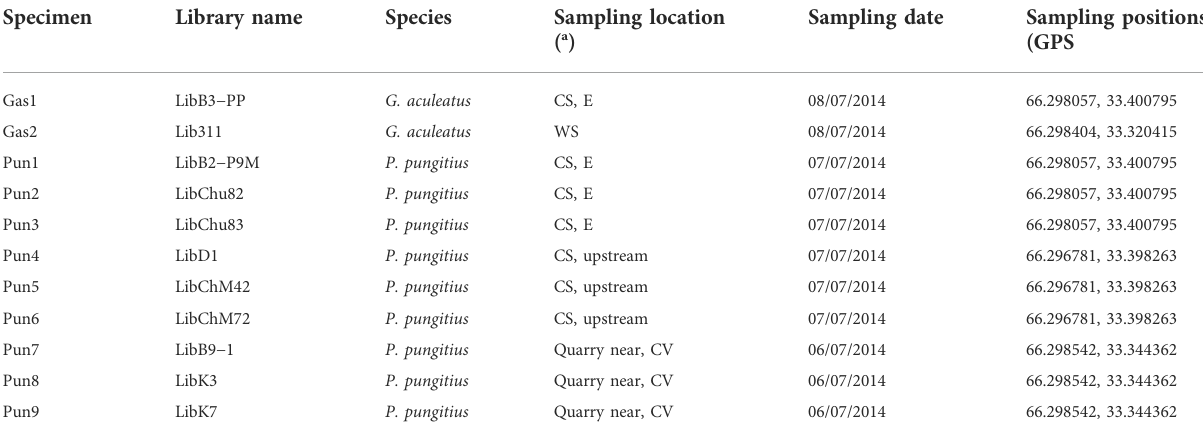
TABLE 1 Nomenclature and sampling location of the three- and nine-spined stickleback ( G. aculeatus and P. pungitus, respectively) specimens used in this study.